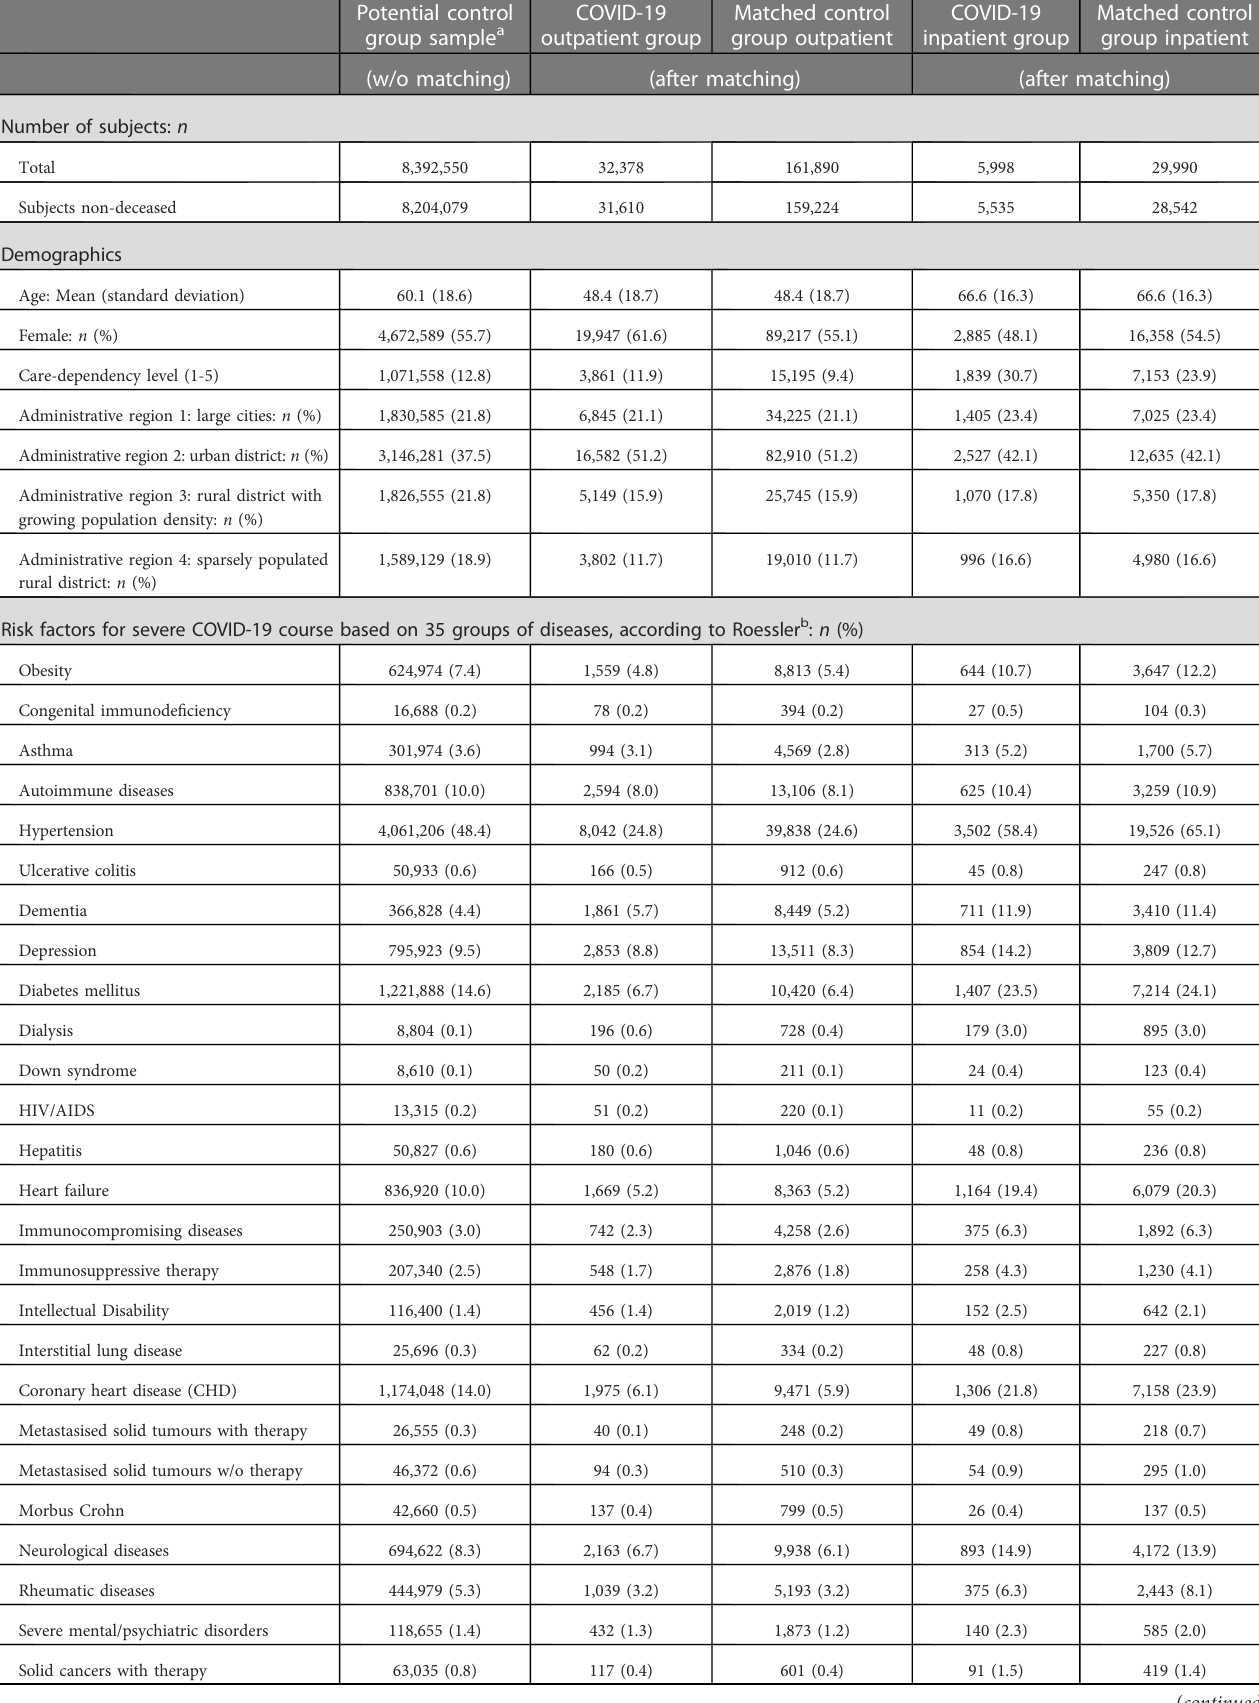
TABLE 1 Characteristics of the study